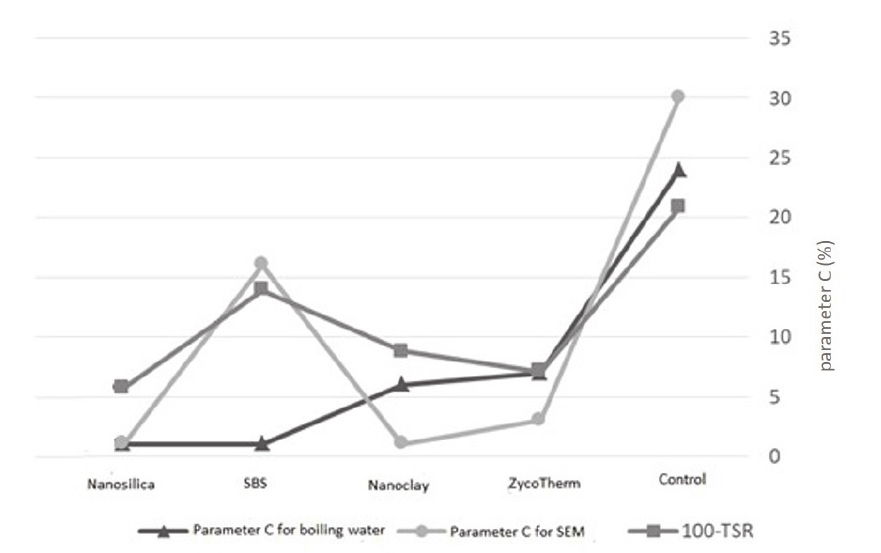
Figure 8: Investigation into results of parameter C for boiling water and SEM tests and results of (100-TSR)